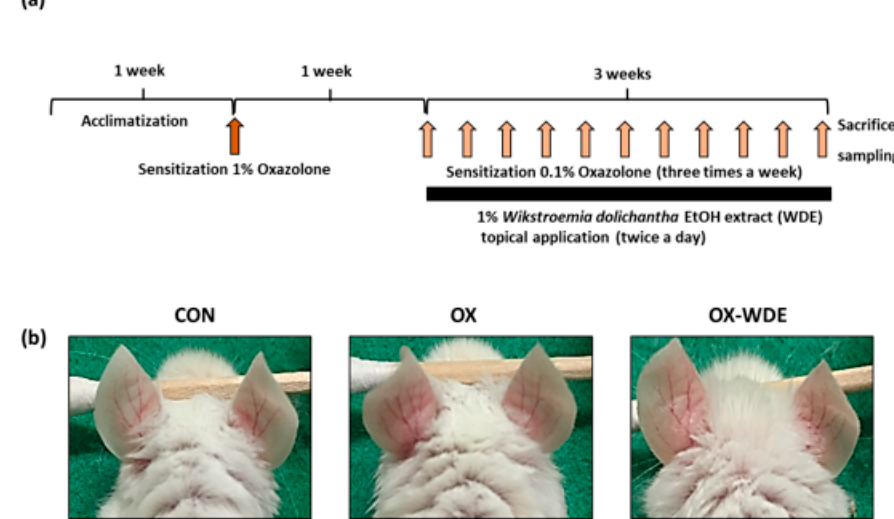
Figure 1. Effects of WDE on the development of oxazolone-induced AD-like symptoms in the ears of BALB/c mice. ( a ) Schematic representation of the experiment. ( b ) Clinical features of AD-like skin lesions. WDE: EtOH extract of Wikstroemia dolichantha , CON: control group, OX: oxazolone-treated group, OX-WDE: oxazolone and 1% W. dolichantha EtOH extract-treated group.